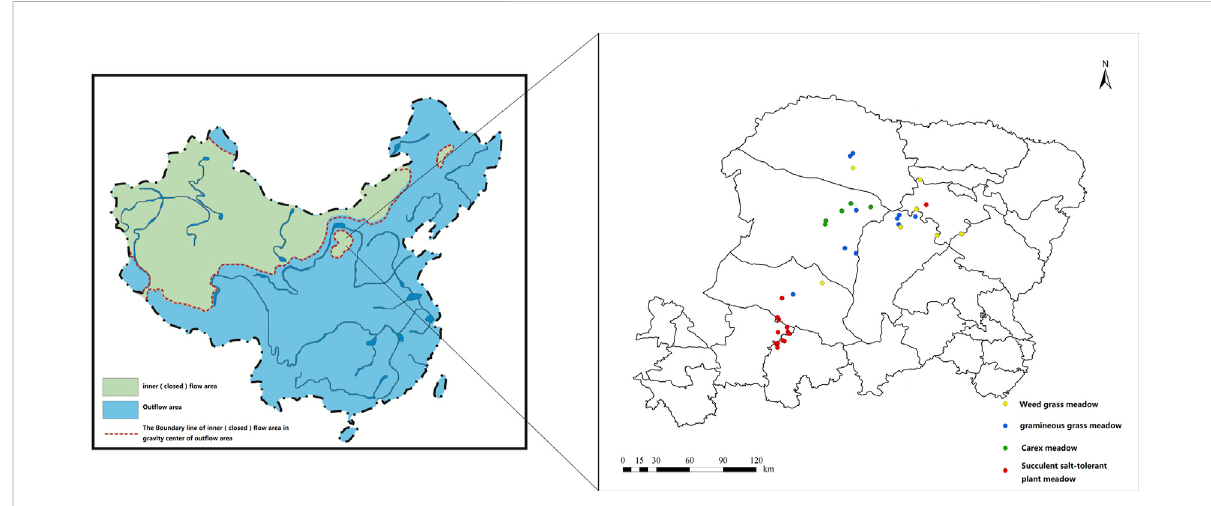
FIGURE 1 Distribution of the study area and sampling